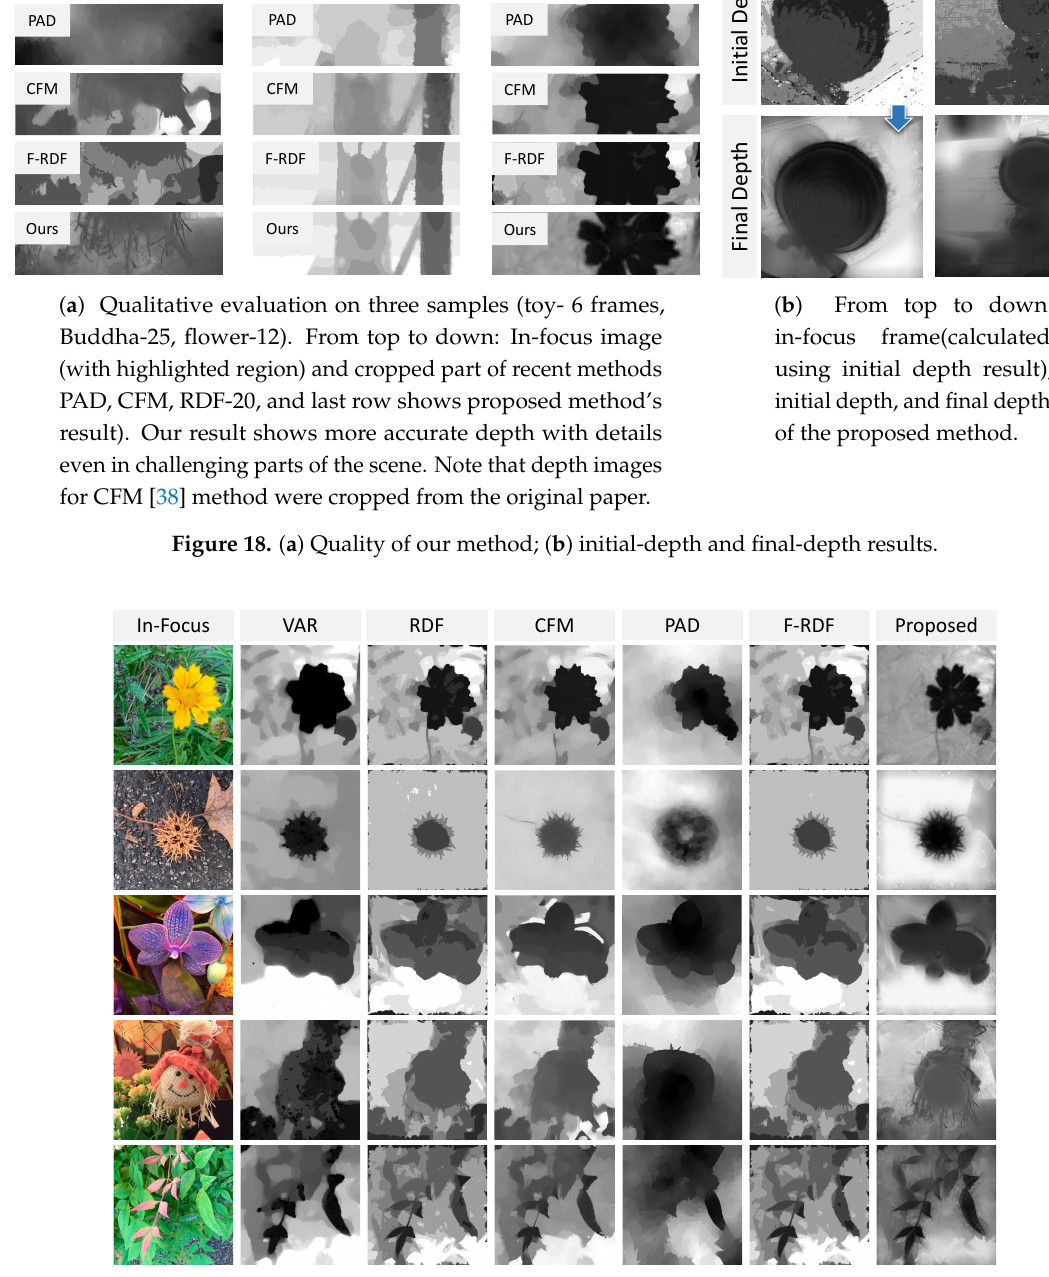
Figure 19. Qualitative evaluation on LFSD dataset [28] with recent (state-of-the-art) methods. The proposed method can provide depth with detail information even at complex scene. Note that depth image for CFM [38] method was cropped from the original